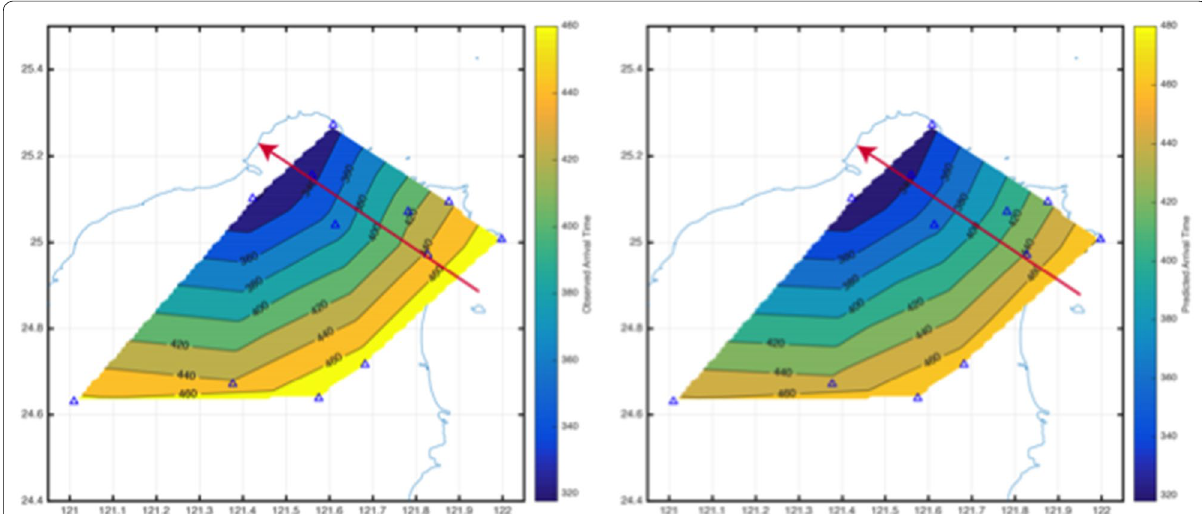
Fig. 6 Isochrones map for the observed ( left ) and the predicted shockwave arrival times ( right ) at seismic and infrasound stations of northern Tai- wan. The color bar (right of each map) shows the arrival time in seconds (from an arbitrary reference time). The red arrow indicates the approximate 2D trajectory of the